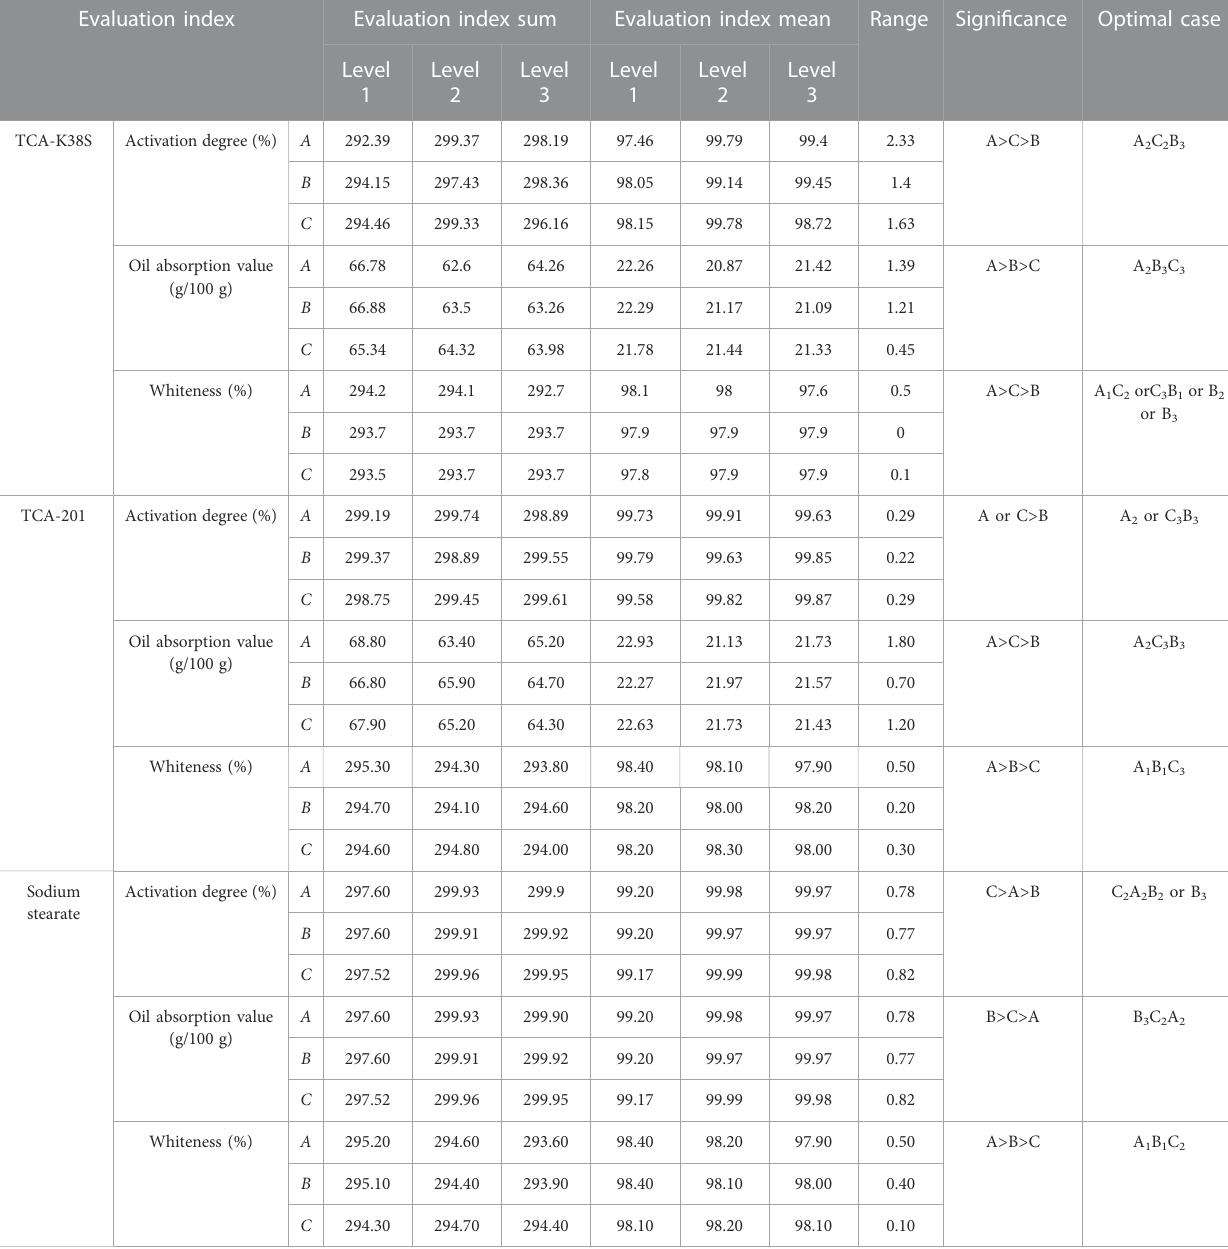
TABLE A1 Range analysis of orthogonal